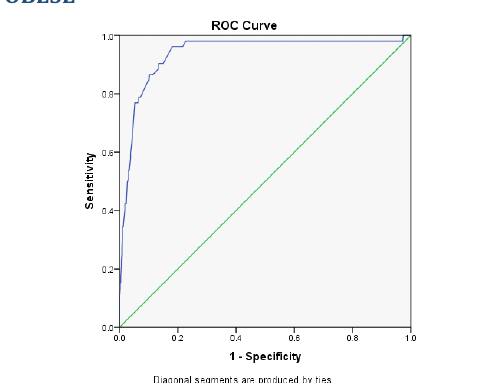
Fig 1a - ROC curve of MUAC in predicting underweight